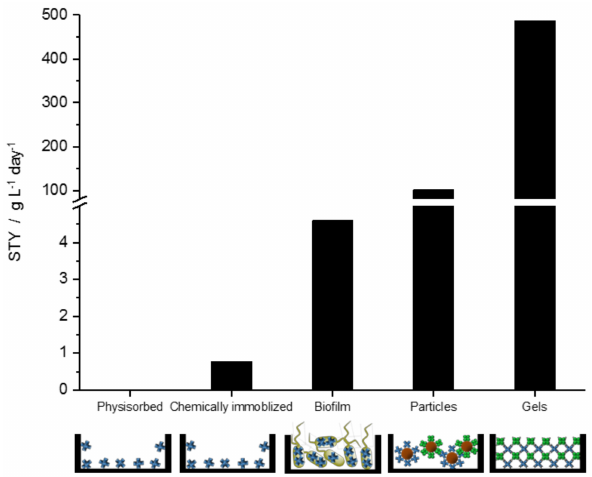
Figure 4. Diol 3d space–time yields (STY) obtained for the various different flow-biocatalysis reactor modules. Schemes of the chip cross section with the immobilized biocatalyst are shown underneath the corresponding bar